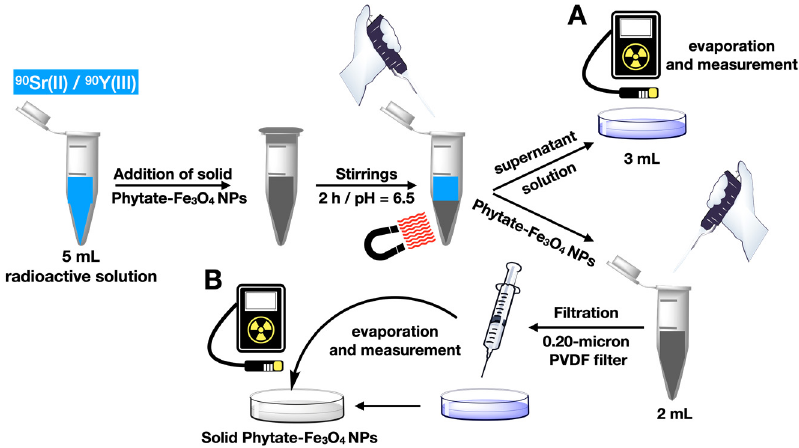
Figure 6. Scheme of the methodology followed for the recovery of radioactive strontium and yttrium from a standard sample. Table 1. Results obtained by applying the 90 Sr (II) and 90 Y(III) uptake methodology using Phy@Fe 3 O 4 nanoparticles.